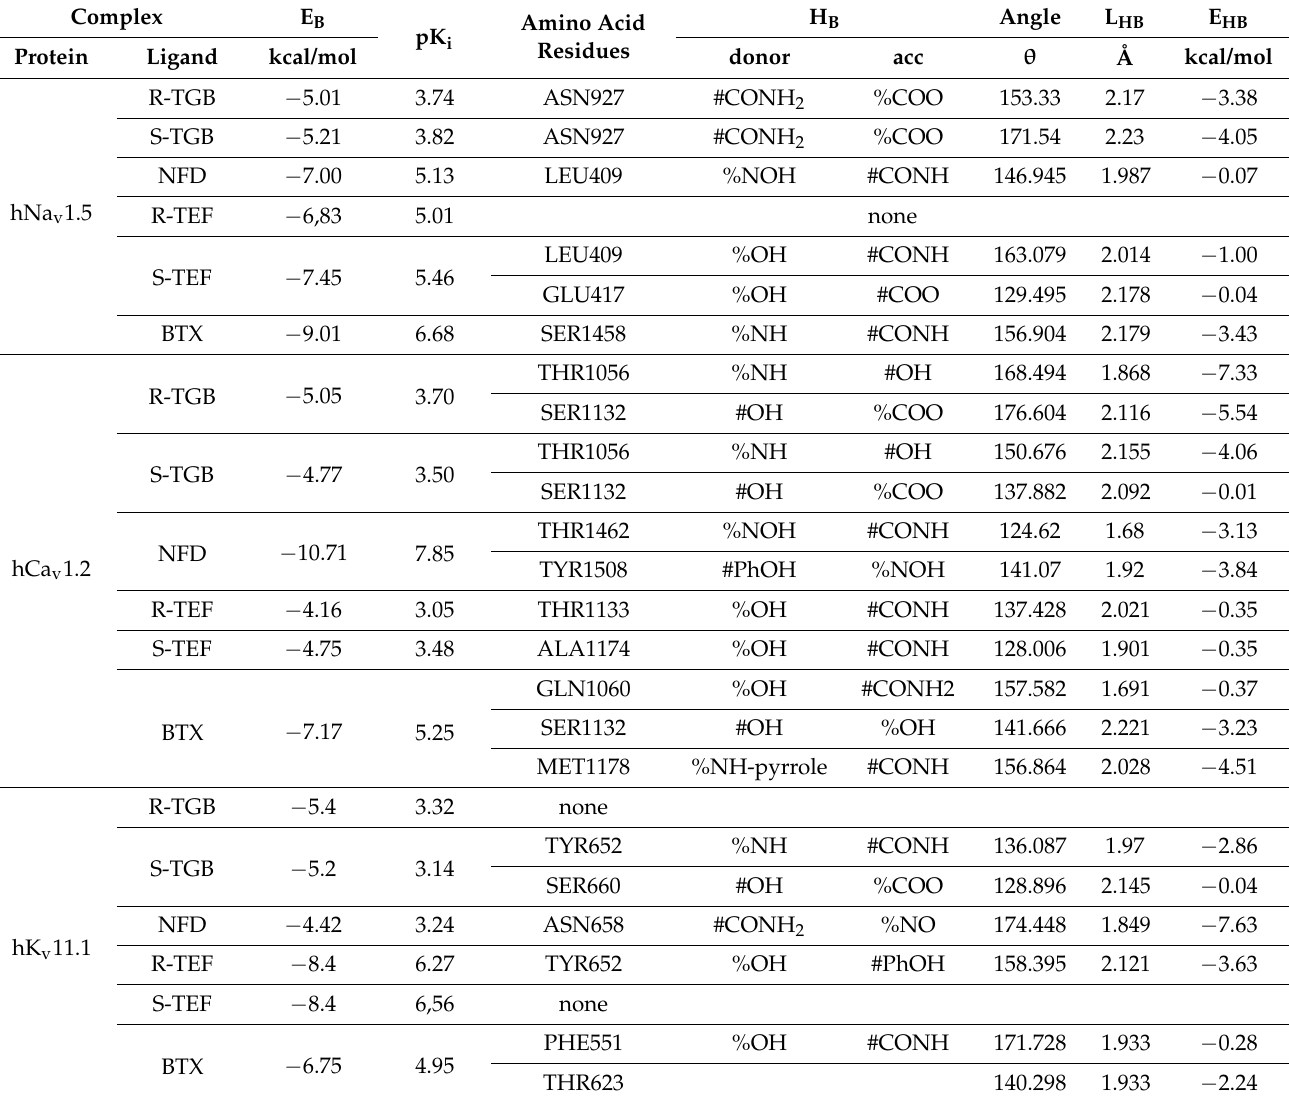
Abbreviations in Table. Components of the investigated complexes: protein-hNav1.5, hCav1.2 and hK v 11.1 (hERG); and ligands, R/S- TGB (R/S-tiagabine), NFD (nifedipine), R/S-TEF (R/S-terfenadine), BTX (batrachotoxin). Other abbreviations: H B —hydrogen bond. acc—hydrogen bond acceptor. Hydrogen bond components: from the ligand % and from the protein #. E B —complex energy binding. θ —hydrogen bond angle. L HB —hydrogen bond length. E HB —hydrogen bond energy. pK i was calculated from the AutoDock4 and estimated inhibition constant K i , which is reported in the AutoDock4